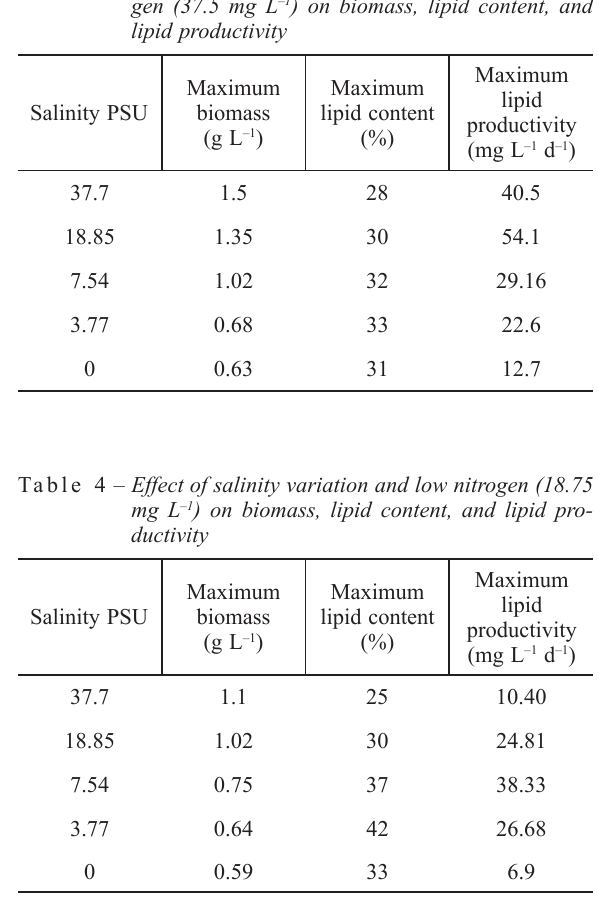
Table 3 – Effect of salinity variation and intermediate nitro- gen (37.5 mg L –1 ) on biomass, lipid content, and